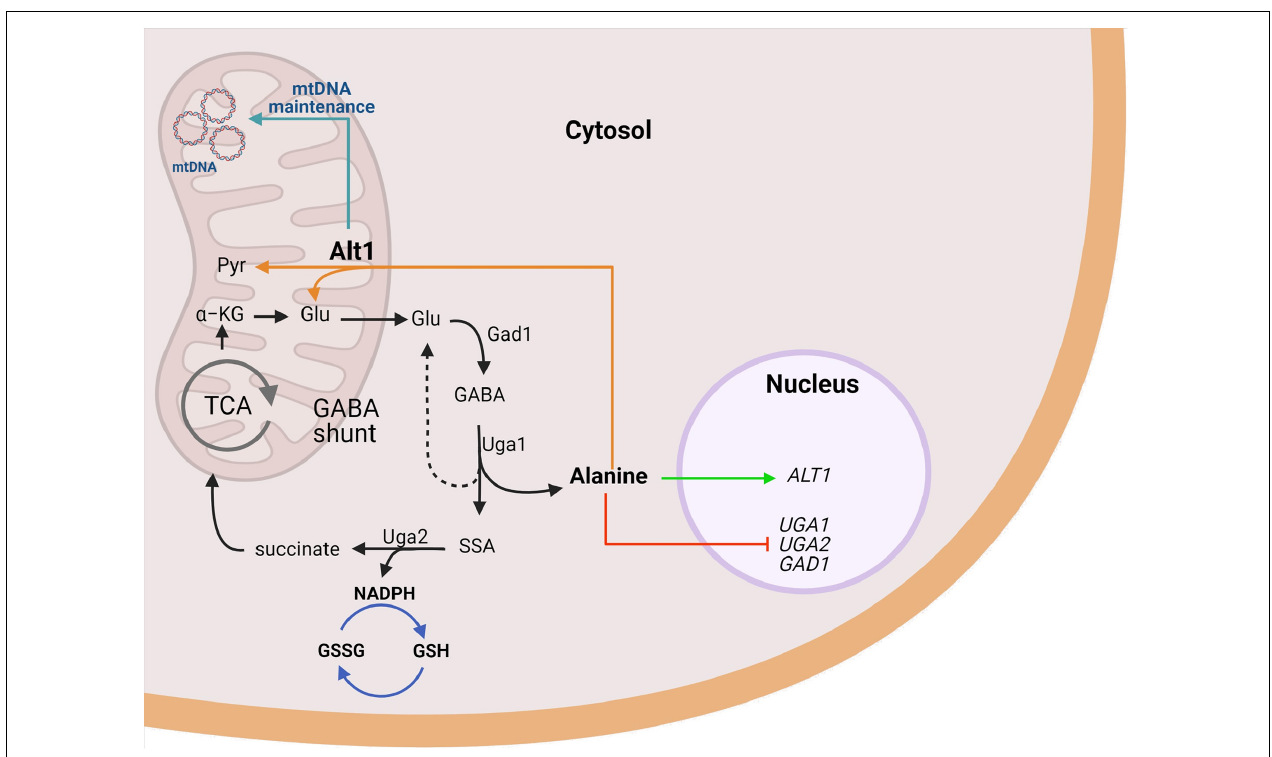
FIGURE 7 | Alanine represses GABA utilization and induces alanine transaminase required for mitochondrial function in S. cerevisiae . Uga1, the sole catabolic pathway degrading GABA in yeast, yields glutamate (dashed line) and alanine (solid line). Alanine exerts a dual coregulator role on the expression, being positive for ALT1 and negative for UGA genes. Glutamate produced by Uga1 or alanine catabolism through Alt1 maintains the GABA shunt. GABA metabolism results in net NADPH production, which promotes defense against oxidative stress through GSH restoring. Furthermore, our results suggest Alt1 displays a moonlight function independent of its alanine transaminase capacity, a role that allows the adequate mitochondrial functioning through mtDNA maintenance due to an unidentified mechanism. Image created with